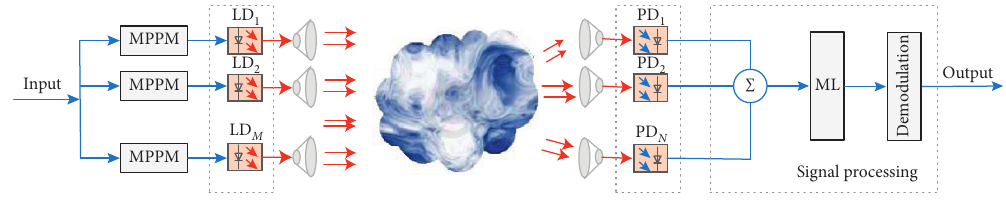
Figure 1: WOC MIMO system with M LDs and N